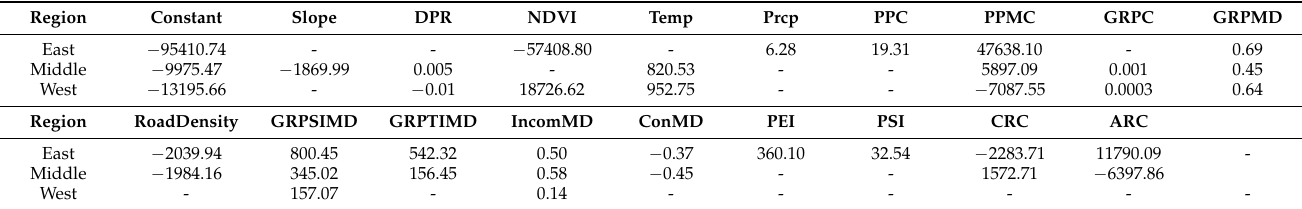
Table 4. Multiple linear regression models for region-based assessment.